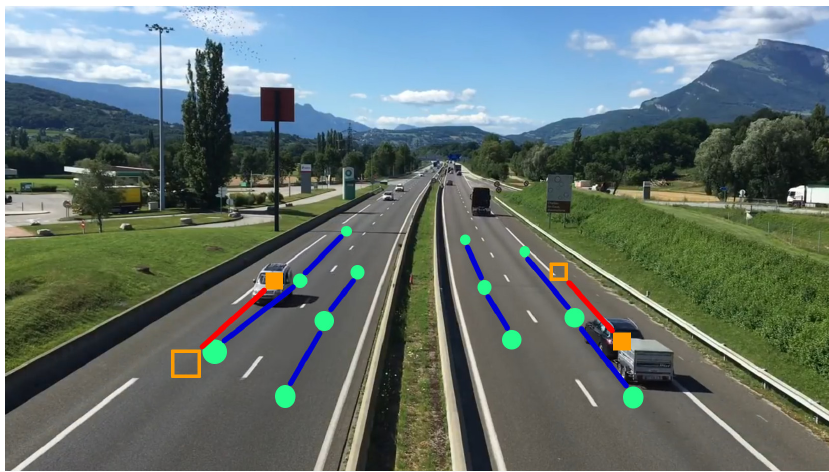
Figure 8. Exemplary prediction model visualization: The position of current detections (filled rectangles) are extended with data from the nearest driving paths (lines) to get future positions (framed rectangles). Screenshot taken from video